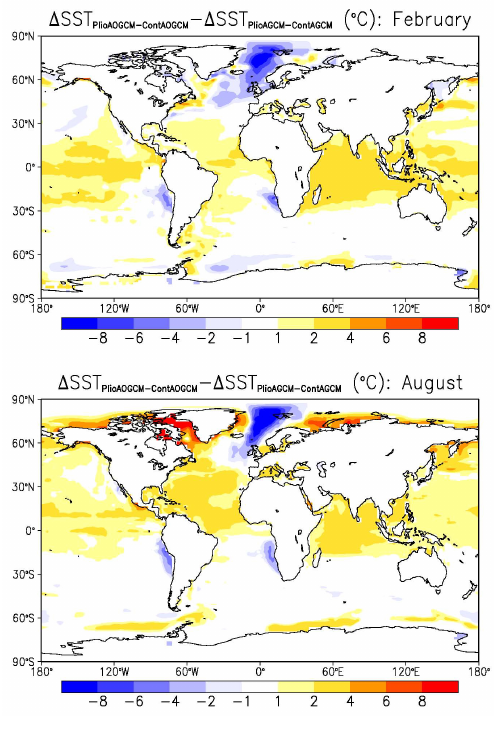
Fig. 12. Difference between the sea surface temperature anomaly in the AOGCM and that prescribed for the AGCM dur- ing February and August, i.e. (SST PlioAOGCM –SST ContAOGCM )– (SST PlioAGCM –SST ContAGCM